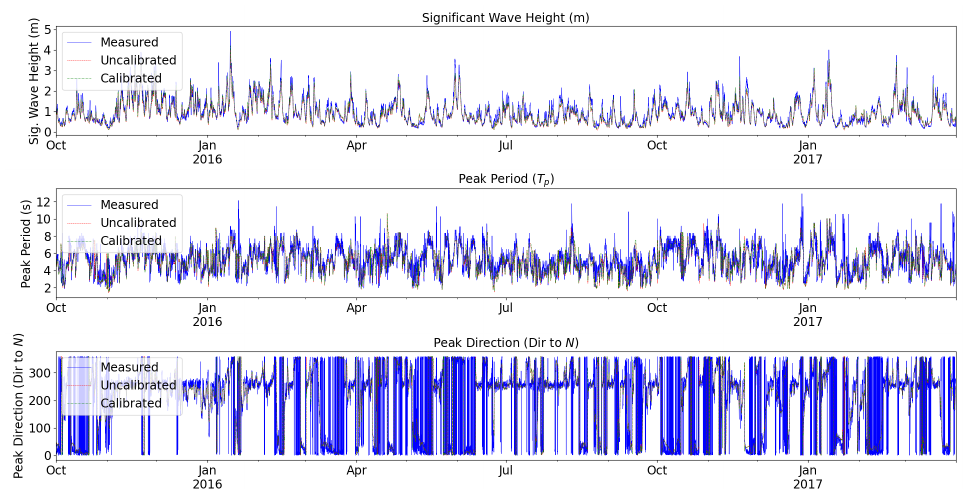
Figure 4. Significant wave height ( top panel), peak period ( centre panel) and peak wave direction ( bottom panel) time series plots for the ECMWF-ERA5 forced SWAN model showing the measured data vs. the uncalibrated SWAN model and calibrated SWAN model for the Kwintebank station.